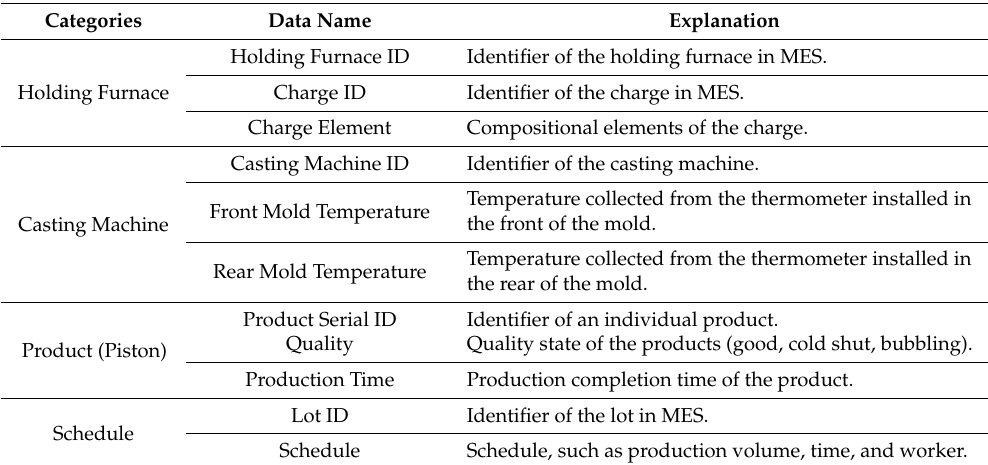
Table 3. Data classification of the casting process.